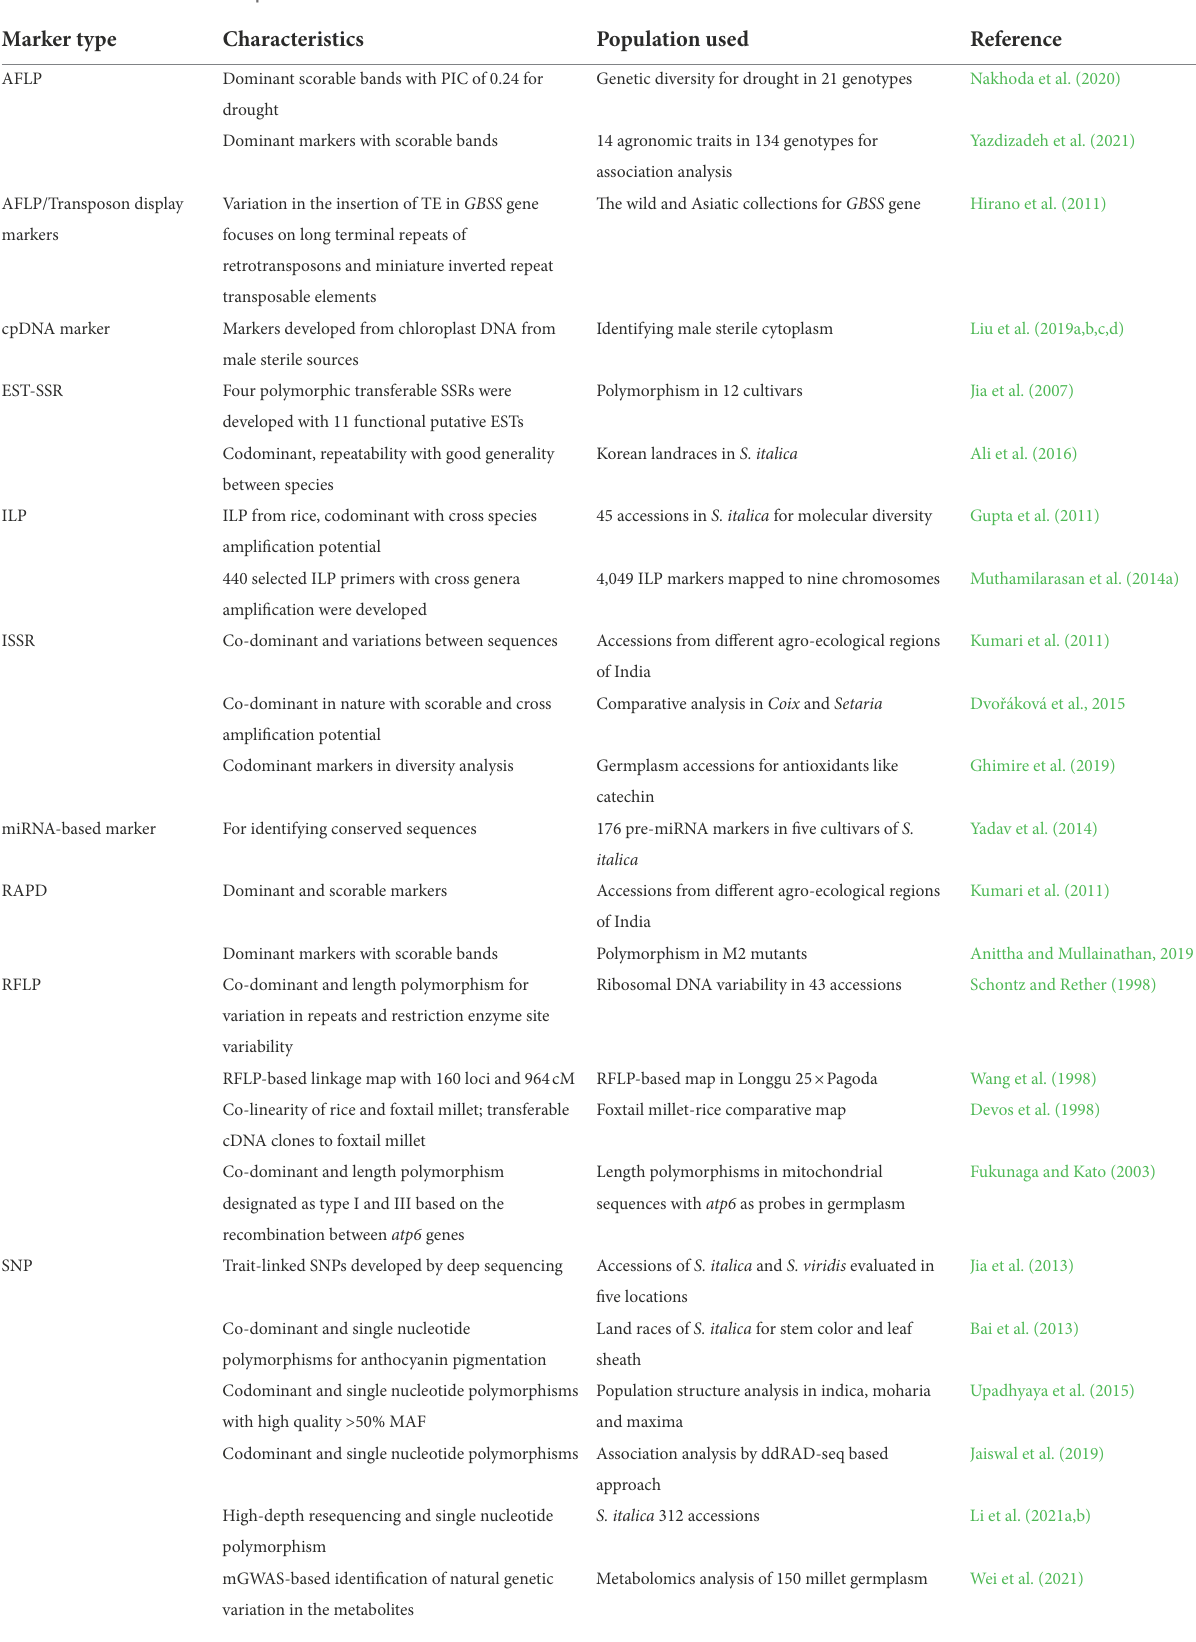
TABLE 1 List of markers developed in Setaria and their characteristic